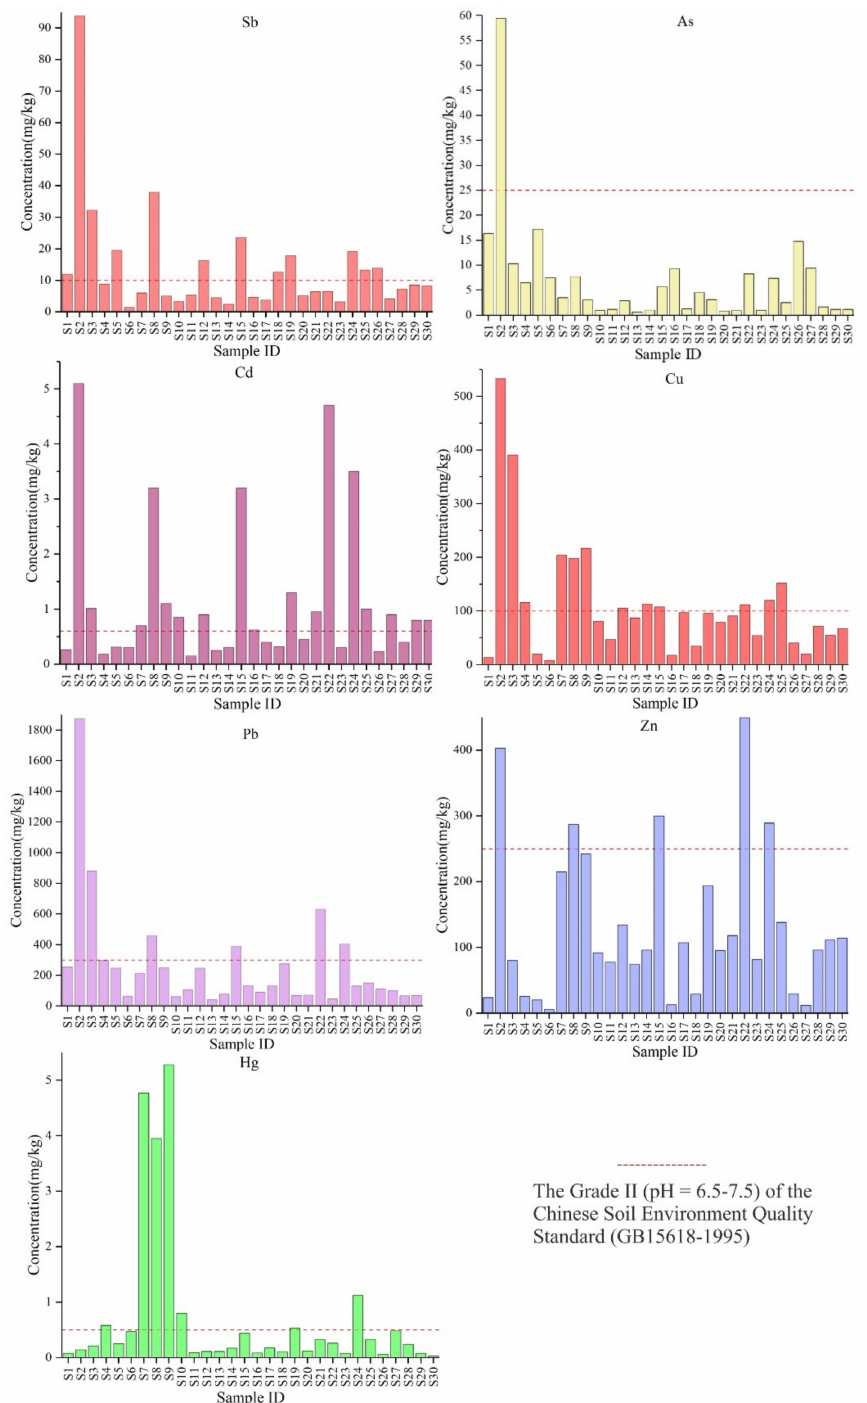
Figure 2. Spatial distribution of the studied PTES concentrations in soils (The critical values from the Chinese Soil Environment Quality Standard (GB15618-1995) were marked for all